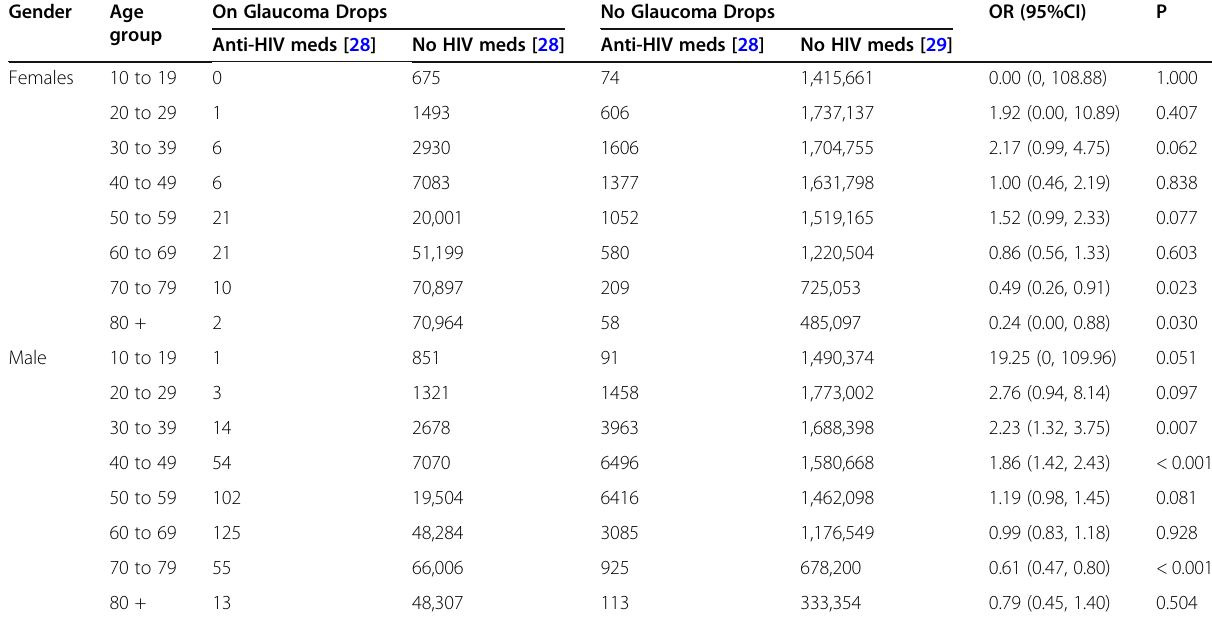
Table 3 Rates of anti-HIV and anti-glaucoma medication by sex and age group in 2016 Australian residents Gender